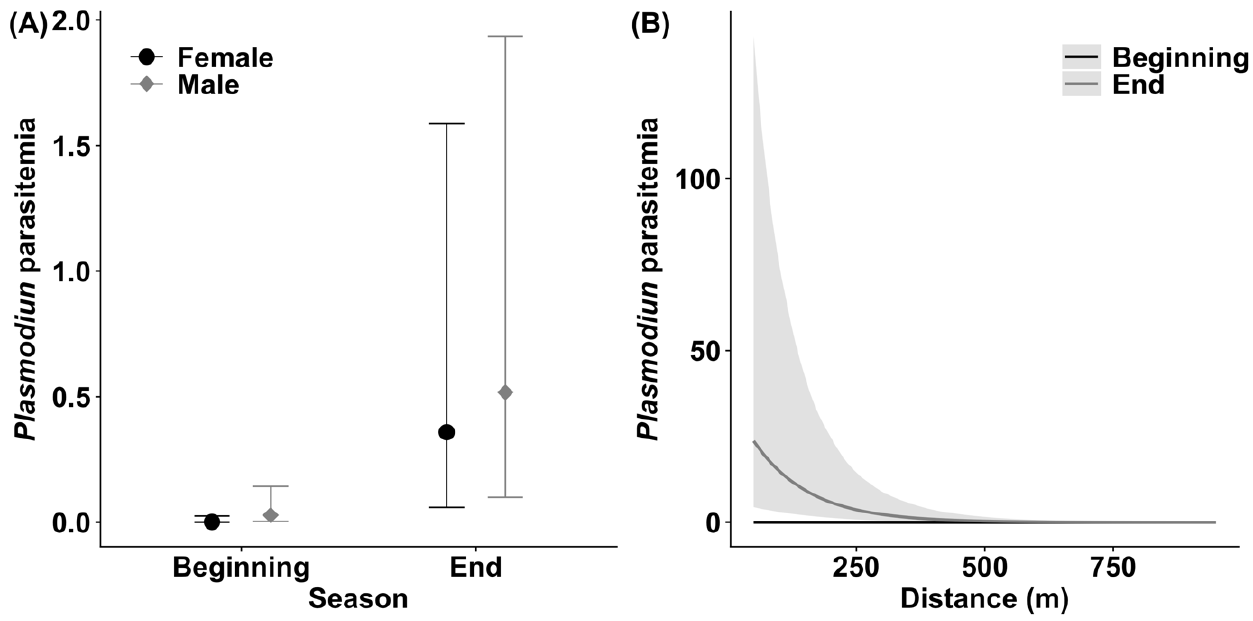
Figure 4. ( A ) Plasmodium parasitemia in male and female Pied Flycatchers at the beginning and end of the breeding season. Error bars represent 95% credibility intervals. ( B ) The relationship between Plasmodium parasitemia and the distance to the nearest water bodies at the beginning and end of the breeding season. Solid lines show the estimated trendlines by the model, and grey-shaded areas represent 95% credibility intervals.